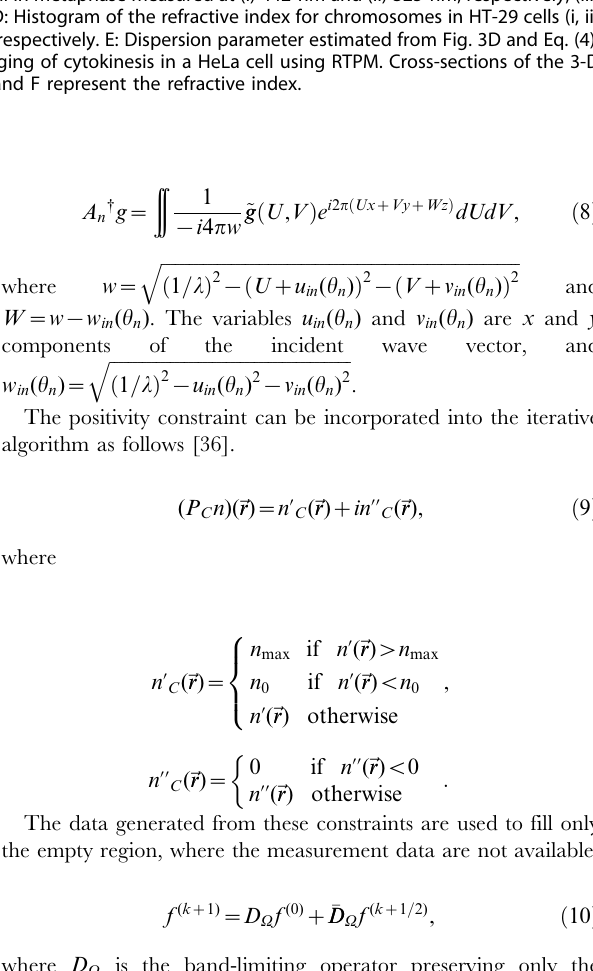
Figure S1 Schematic layout of the experimental set-up (TPM & CLSM) and performance test of CLSM. Figure S2 Retrieval of scattered fields and 3-D mapping based on the Fourier diffraction theorem. Figure S3 Sensitivity analysis of the regularization parameter.